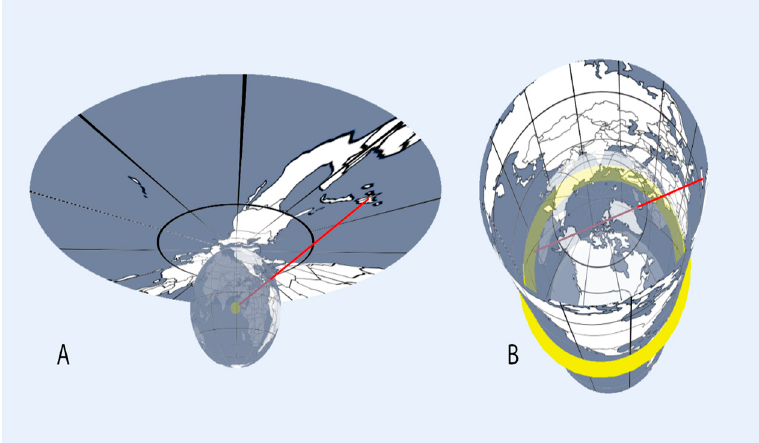
Figure 5. Two configurations of the light source: ( A ) point light source placed in the center of the globe; ( B ) circular light source representing multiple varying positions of the light source depending on the longitude. The light rays used to draw specific points on the projection surface are highlighted in red.